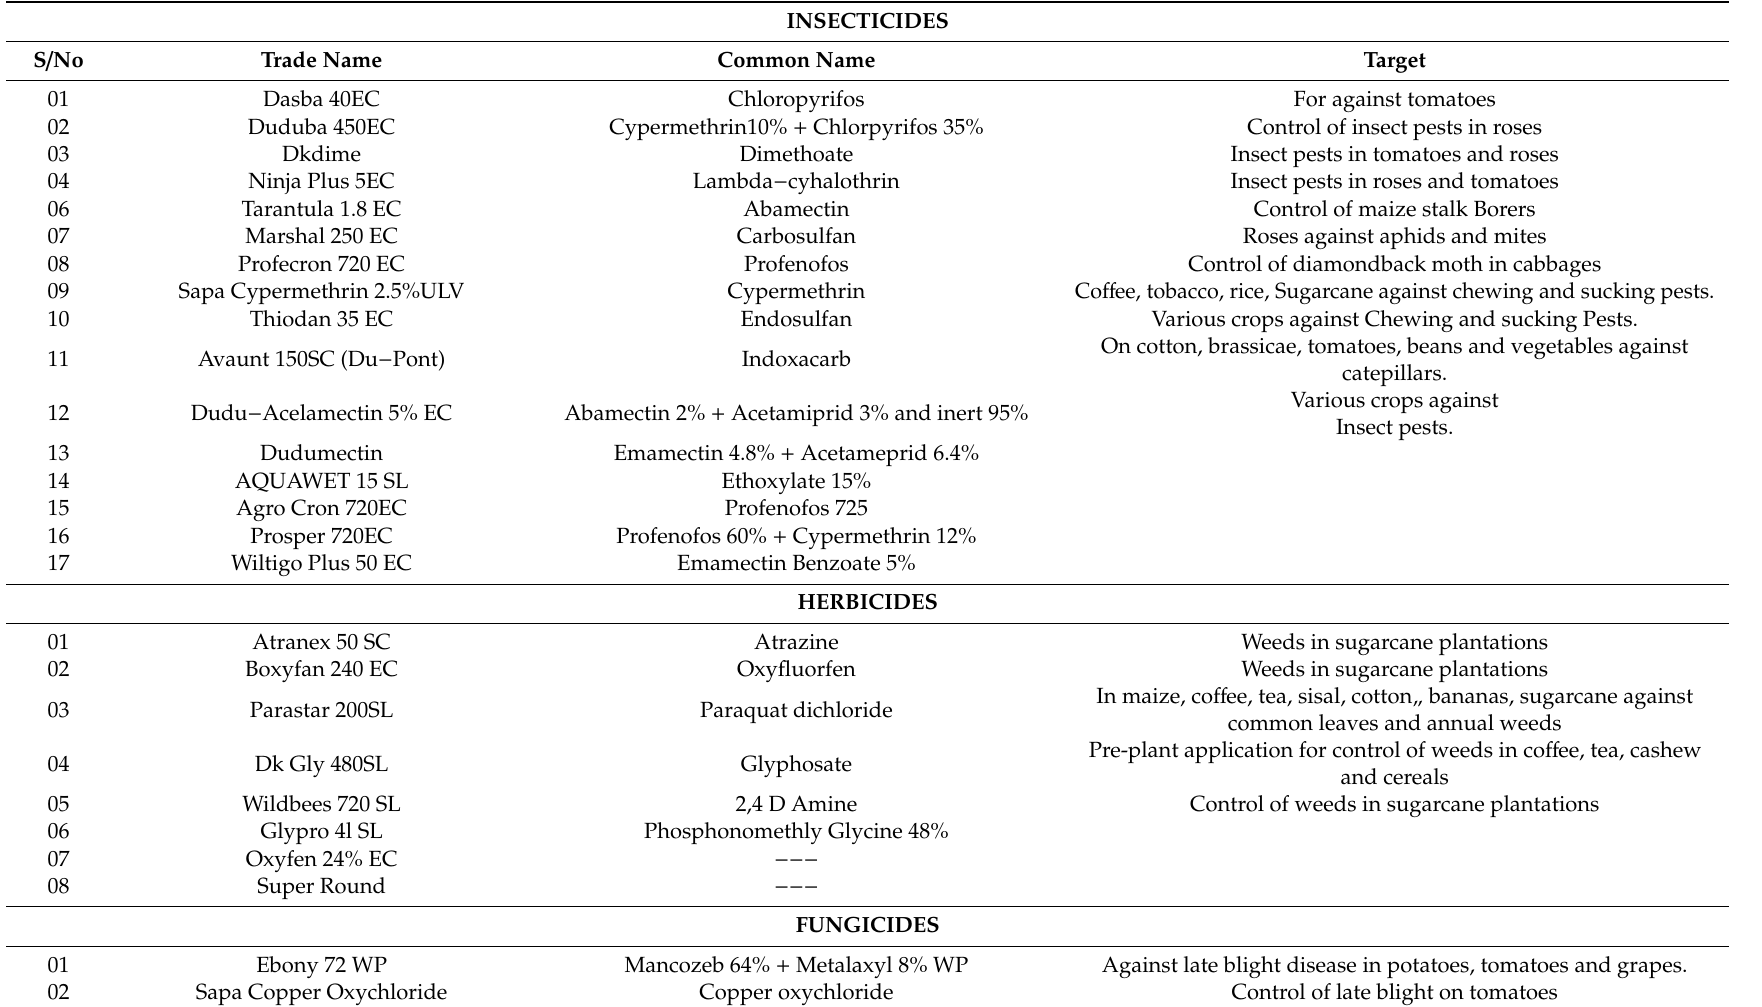
Table A5. Types of Pesticides used in the Kahe catchment in Lower plain